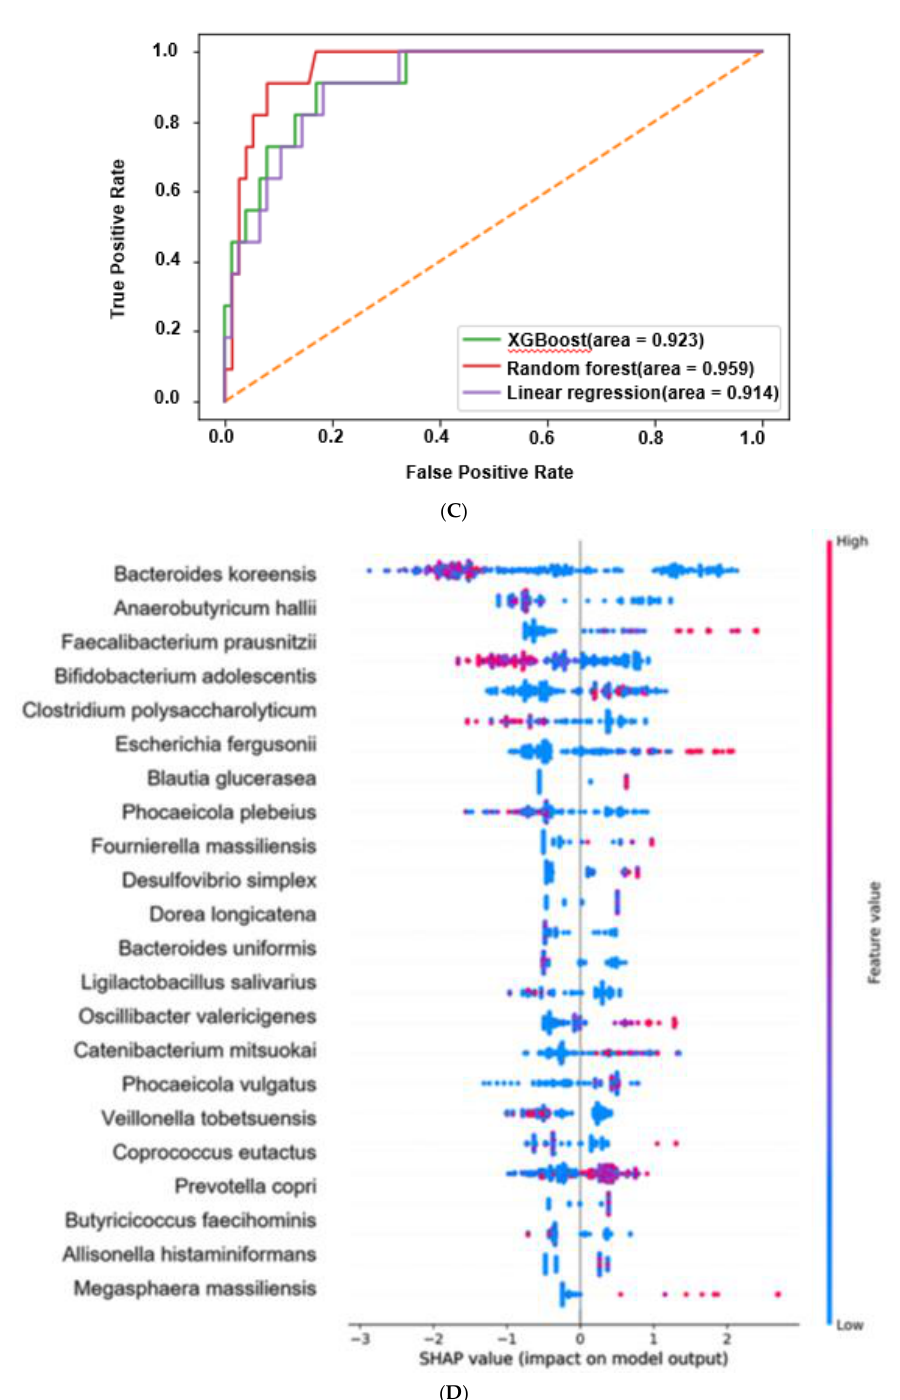
Figure 4. Primary bacteria between the type 2 diabetes (T2DM) and healthy Asians at the species level by XGBoost in each enterotype. ( A ) The area under the curve (AUC) of the receiver operating characteristic (ROC) in the prediction model for fecal bacteria at the species level in the comparison between the T2DM and healthy groups in ET-L; ( B ) Relative abundance of fecal bacteria at the species level between the T2DM and healthy groups in the prediction model in ET-L; ( C ) Area under the curve (AUC) of ROC in the prediction model for fecal bacteria at the species level in the comparison between the T2DM and healthy groups in ET-P; ( D ) Relative abundance of fecal bacteria at the species level between the T2DM and healthy groups in the prediction model in ET-P; ET-L: Enterotype Lachnospiraceae; ET-P: Enterotype